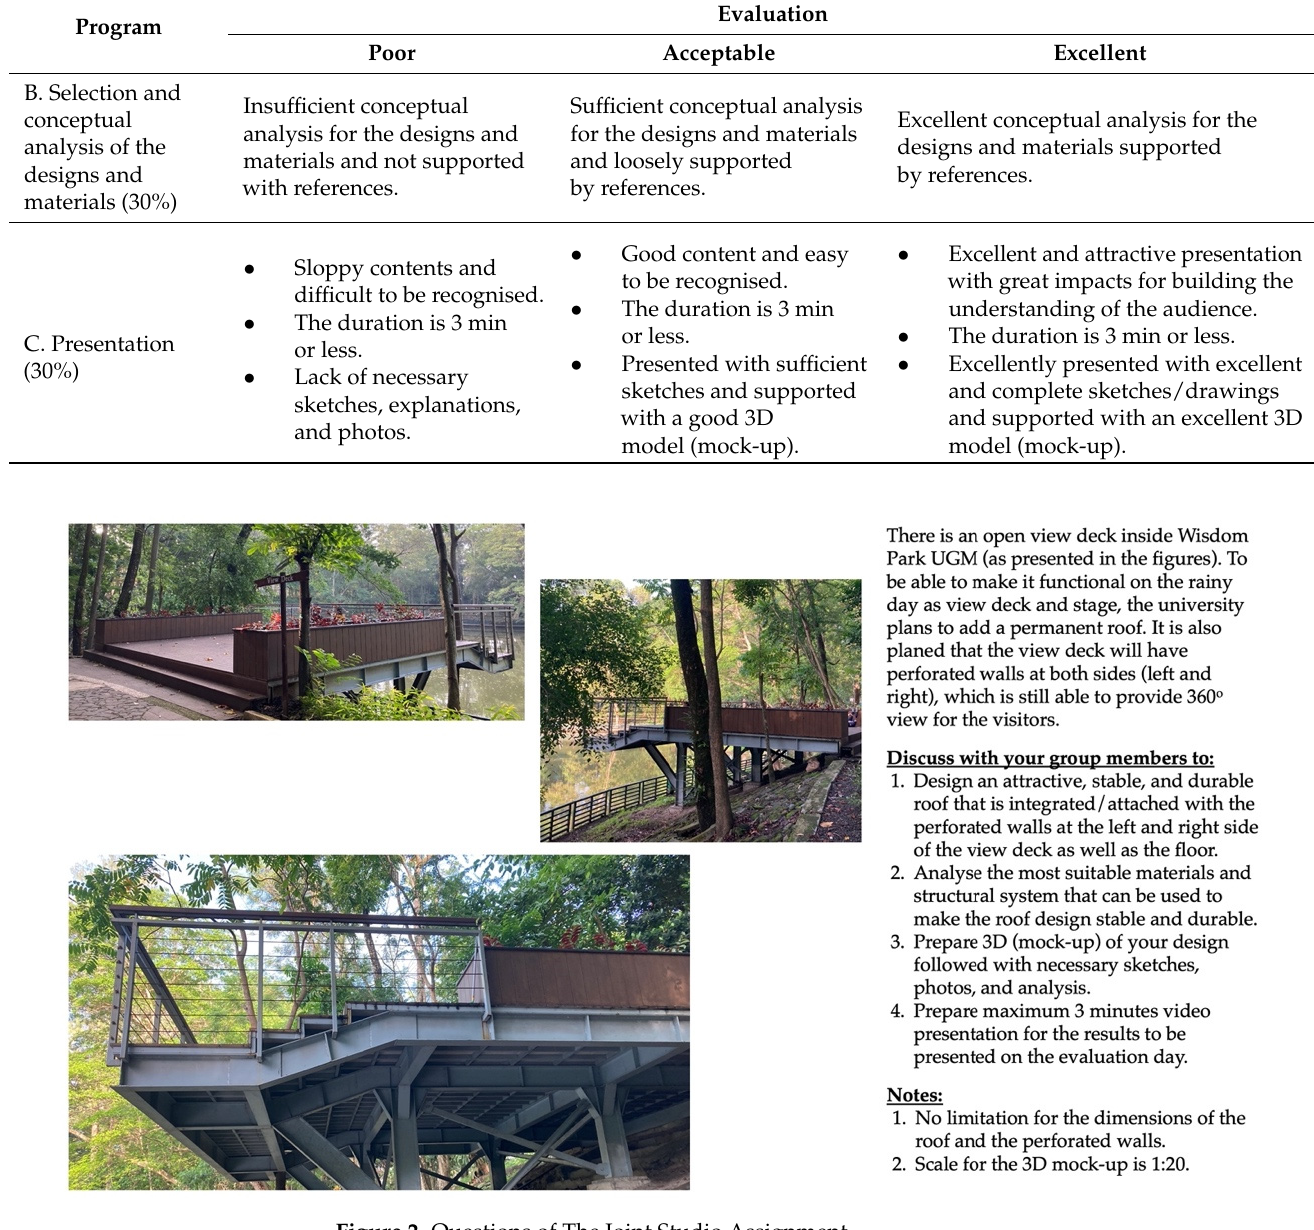
Figure 2. Questions of The Joint Studio Assignment. Table 6. Rubric of evaluation.